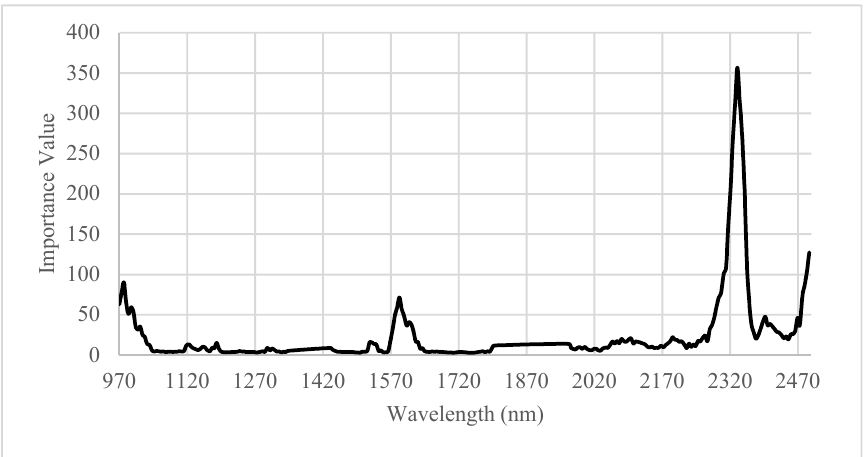
Figure 8. Gini importance of wavelength derived from the RF algorithm.